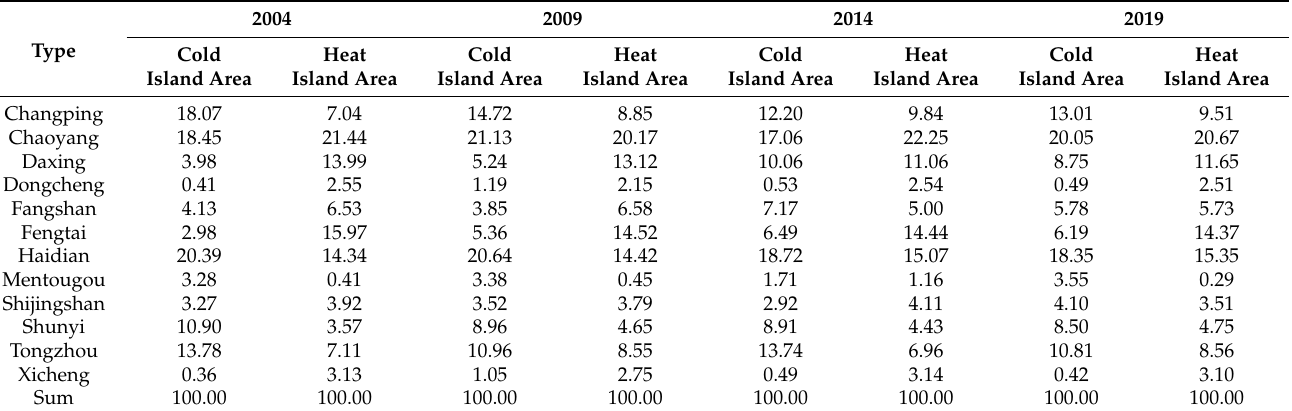
Table 4. Proportions of cold and heat islands within the sixth ring road of Beijing from 2004 to